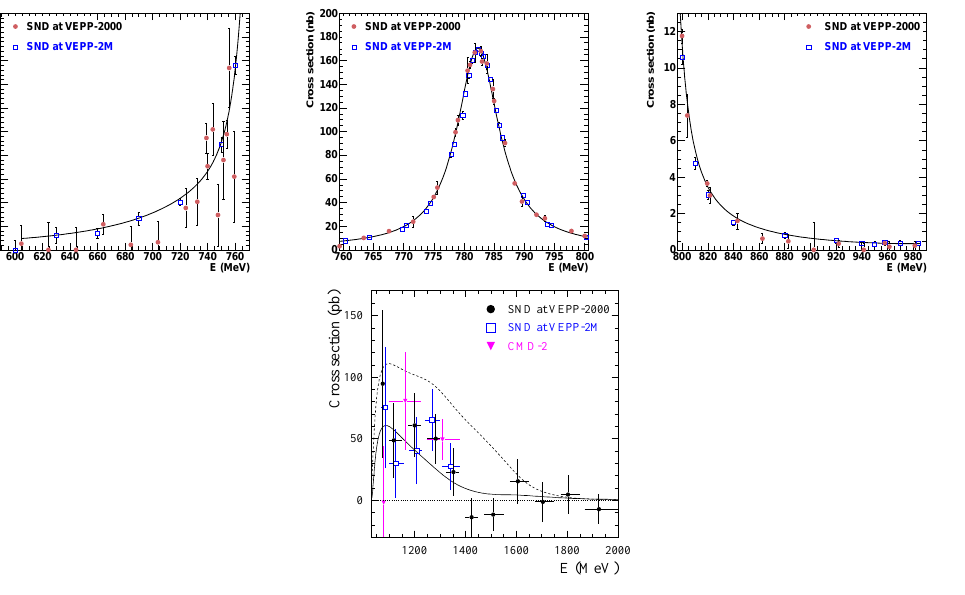
Figure 2. The preliminary results on the e + e − → π 0 γ cross section obtained by SND at VEPP-2000 in di ff erent energy regions in comparison with the SND data obtained at VEPP-2M [5] and CMD-2 (2005) [8]. The curve is the result of the VMD